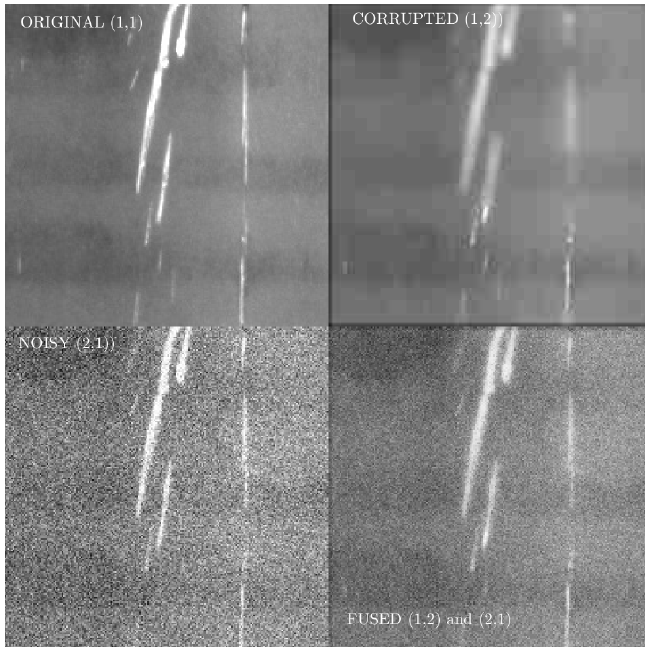
Figure 12. Montage of images with the fused version of the noisy and corrupted image ver- sions